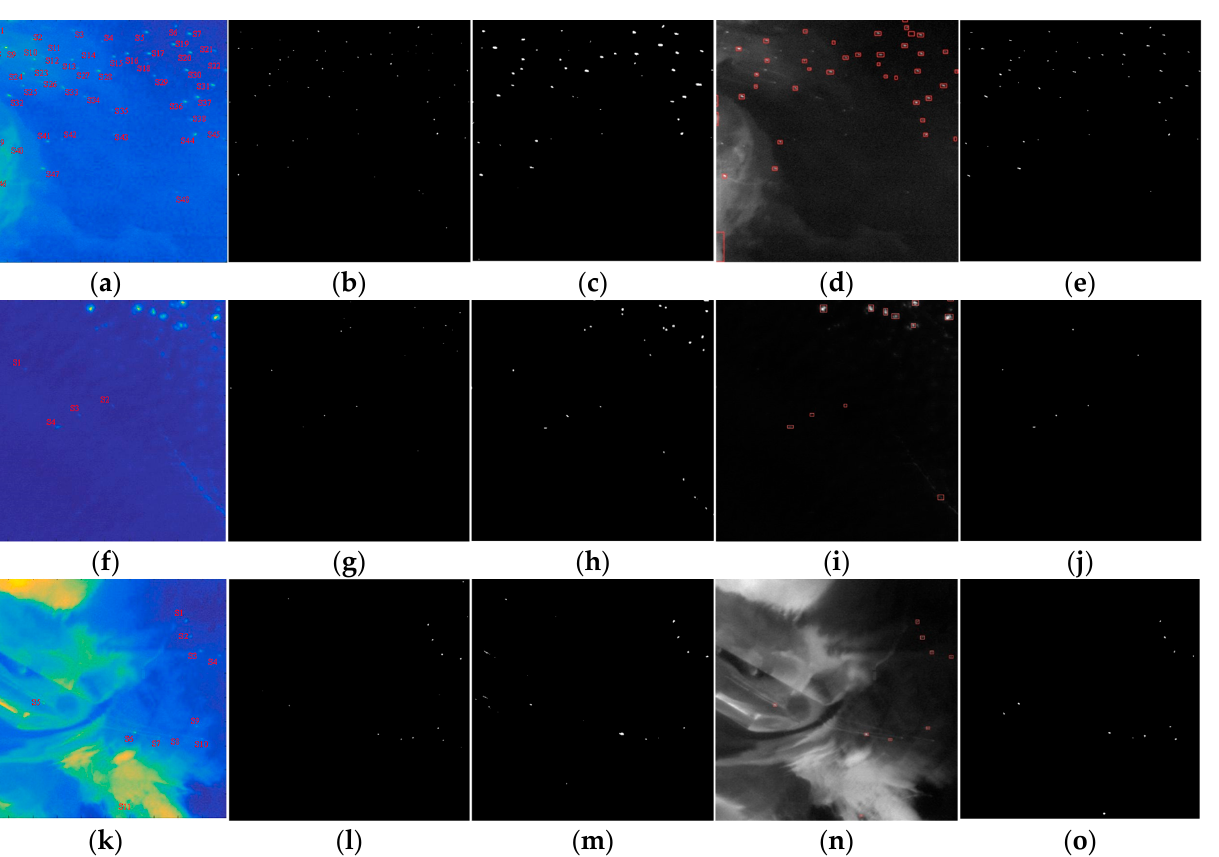
94.90 The ship trajectories of two ROIs veri fi ed by AIS data are utilized to estimate the motion states. Figure 15 presents the proximity of motion states between the tracking re- sults and AIS data in fi ve frames. Table 2 shows the comparison of estimation error of motion states between our method and others, indicating the high accuracy and reliability